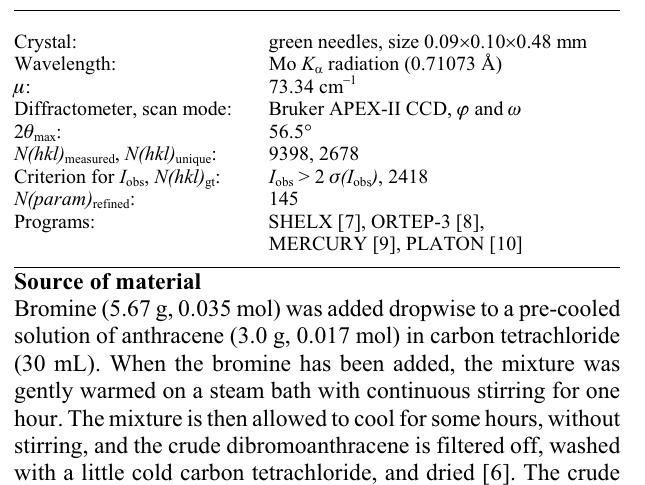
Table 1. Data collection and